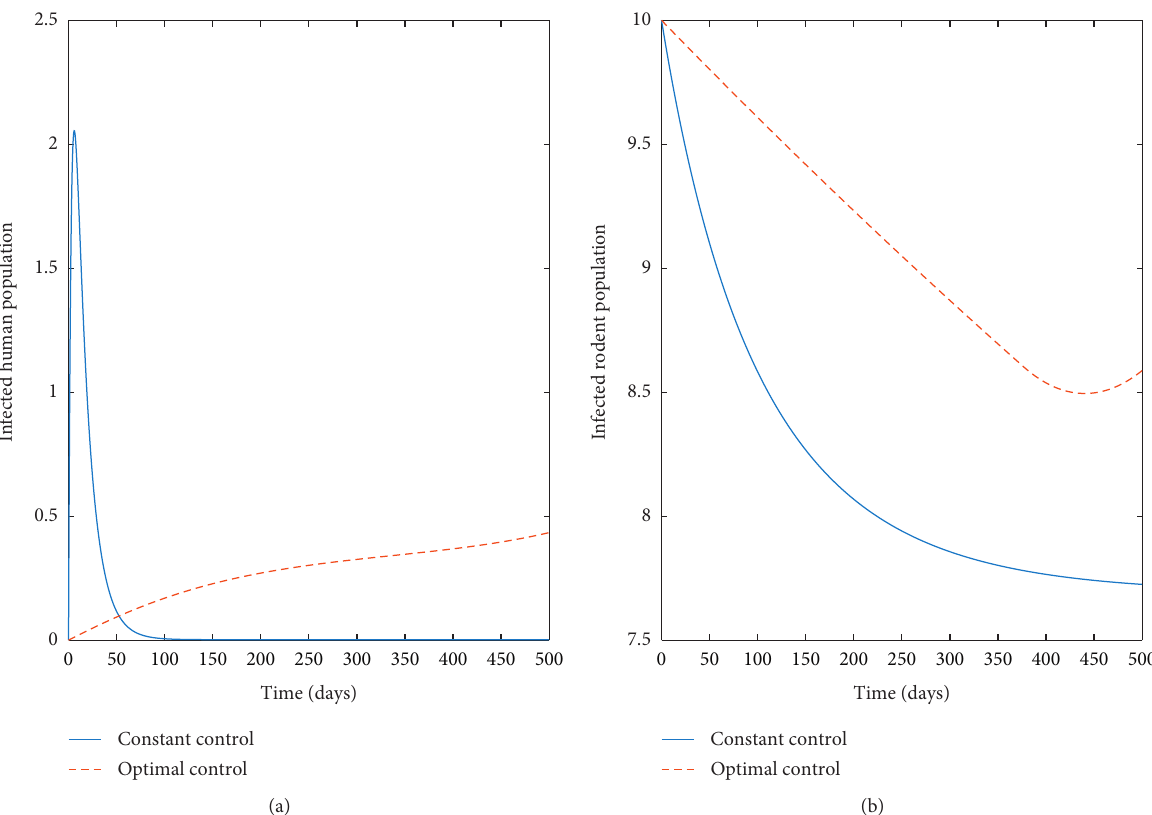
Figure 6: Graphs showing the relationship that exists between the state variables of our model: with constant control and optimal control at a longer